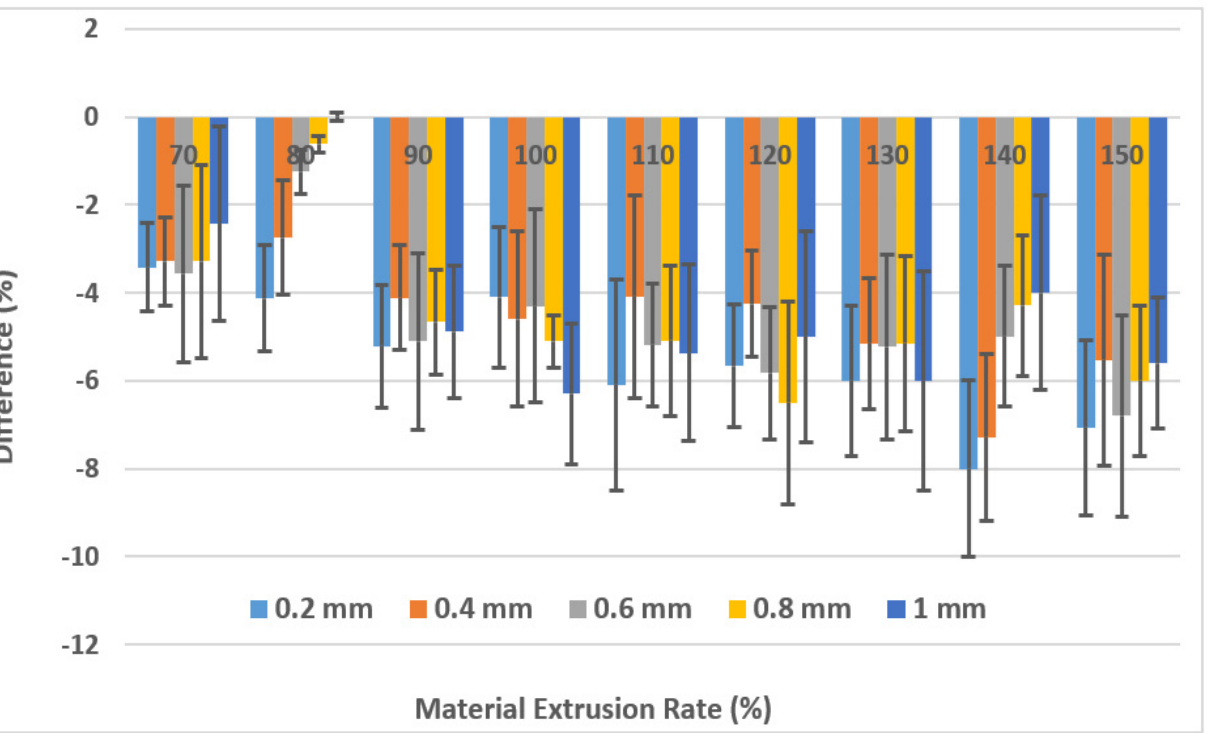
Figure 3. Percentage differences for mass measurements.